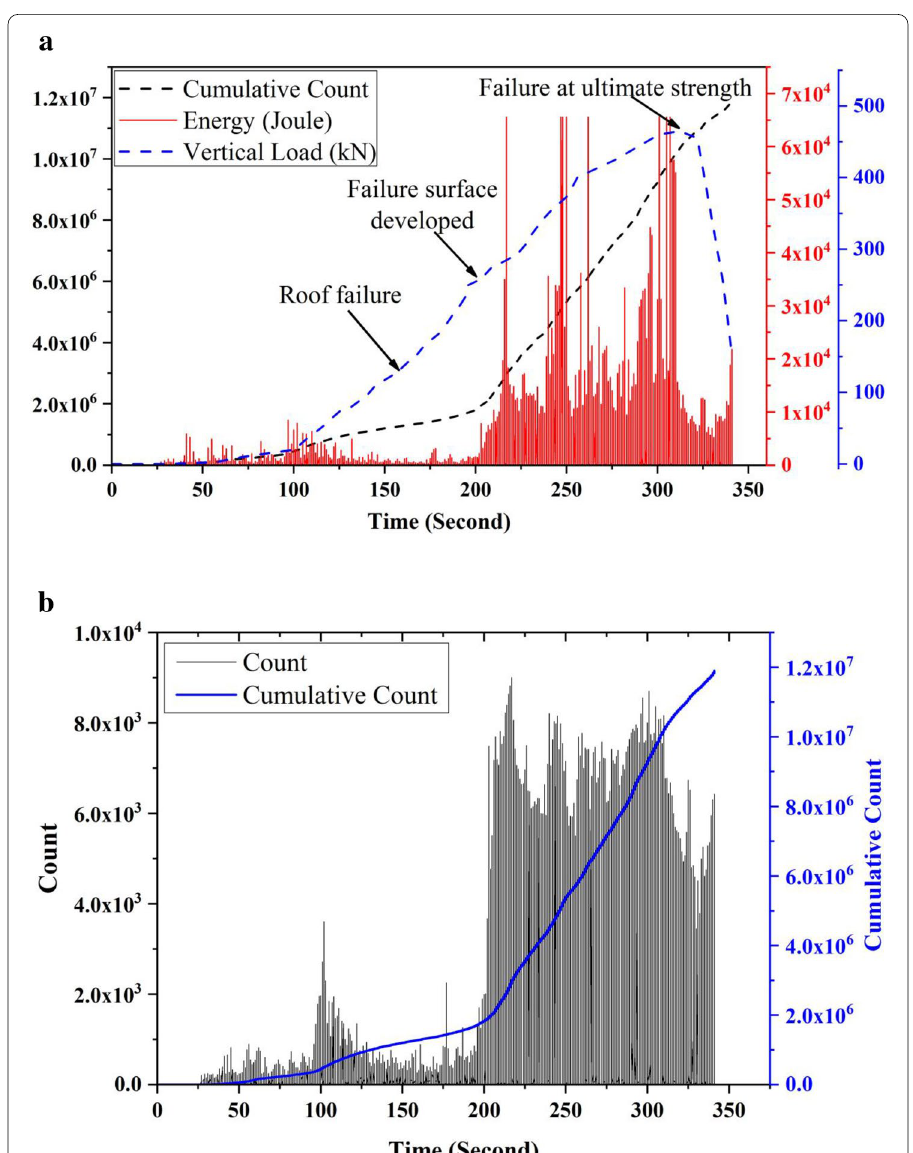
Fig. 5 For Intact rock, ( a ) Plot showing the acoustic behavior and load vs time ( b ) Count and cumulative count vs